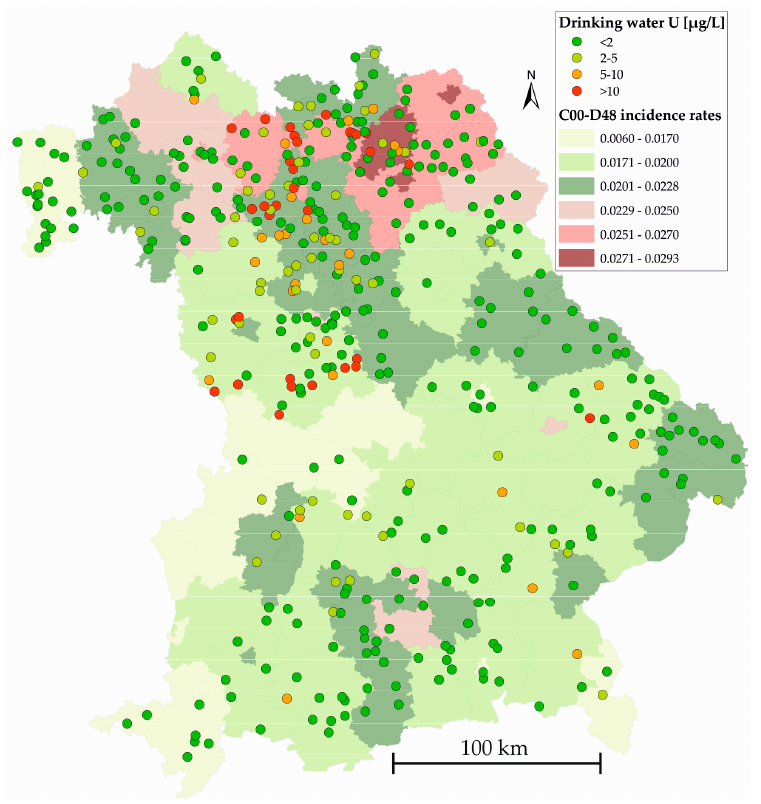
Figure 2. Distribution of U drinking water concentrations and C00 ‐ D48 incidence rates in Bavaria. Greenish colors mark counties below, reddish colors above the national average of 0.0228.